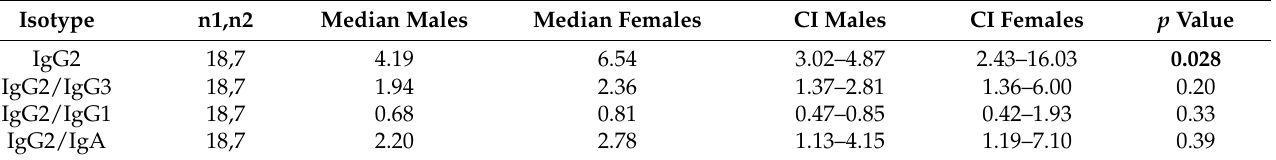
Table 6. Higher preference for IgG2 in females compared to males in a TBS human